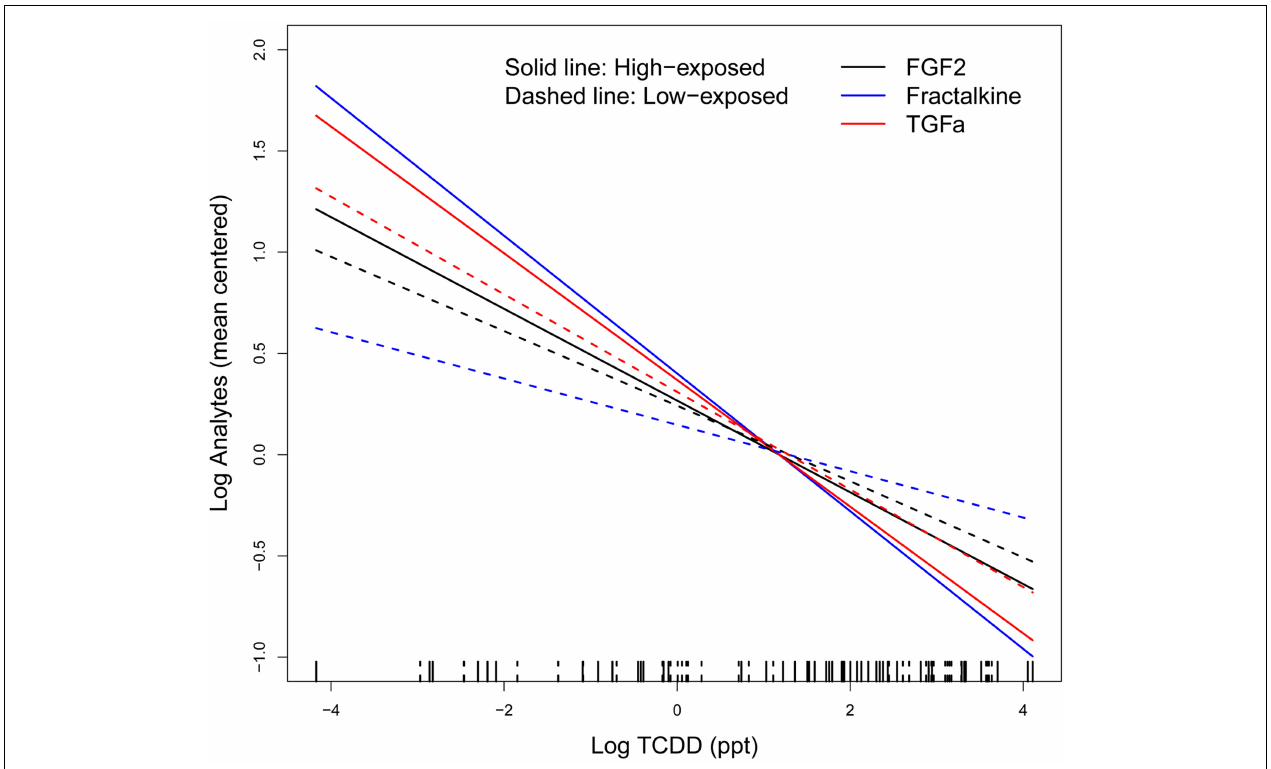
high-exposed subjects and dashed line, low-exposed subjects on the rug plot. A group mean centering parameterization (group’s mean is subtracted from the corresponding individual values) for the models was used to have equivalent models with identical deviance and residual errors;TCDD exposure levels between high- and low-exposed workers largely